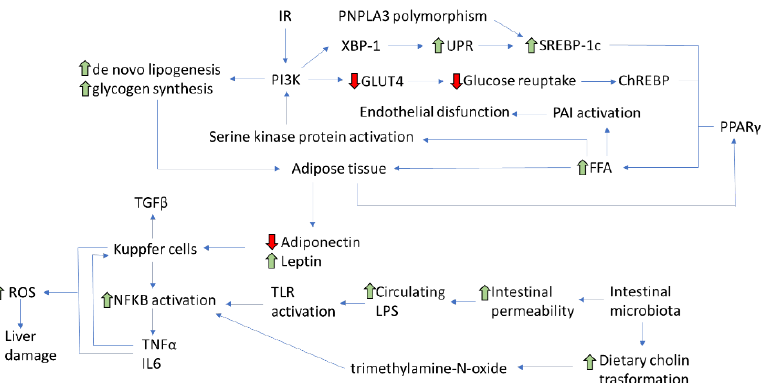
Figure 2. Main pathophysiological pathways involved in NAFLD development (IR: Insulin resistance; PNPLA3: patatin-like phospholipase domain-containing protein 3; XBP: X-box Binging Protein-1; UPR: Unfolded Protein Response; SREBP-:1 sterol regulatory element-binding protein-1; PI3K: phosphatidylinositol 3-kinase; GLUT-4: glucose transporter type-4; ChREBP: carbohydrate-responsive element-binding protein; PAI-1: plasminogen activator inhibitor-1; PPAR-γ: peroxisome proliferator-activated receptor-gamma; FFA: free fatty acids; TGF-β1: transforming growth factor-beta 1; TNF-α: tumor necrosis factor-alpha; NF-κB: nuclear factor kappa-light-chain-enhancer of activated B cells; TLR: toll-like receptors; LPS: lipopolysaccharide; IL6: interleukin -6;